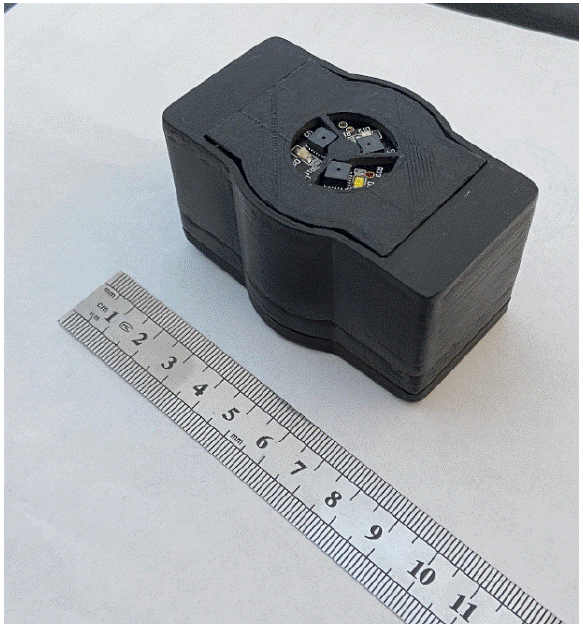
Figure 6. The appearance of the electronic sensor unit of the system, enclosed in a manufactured plastic case. plastic